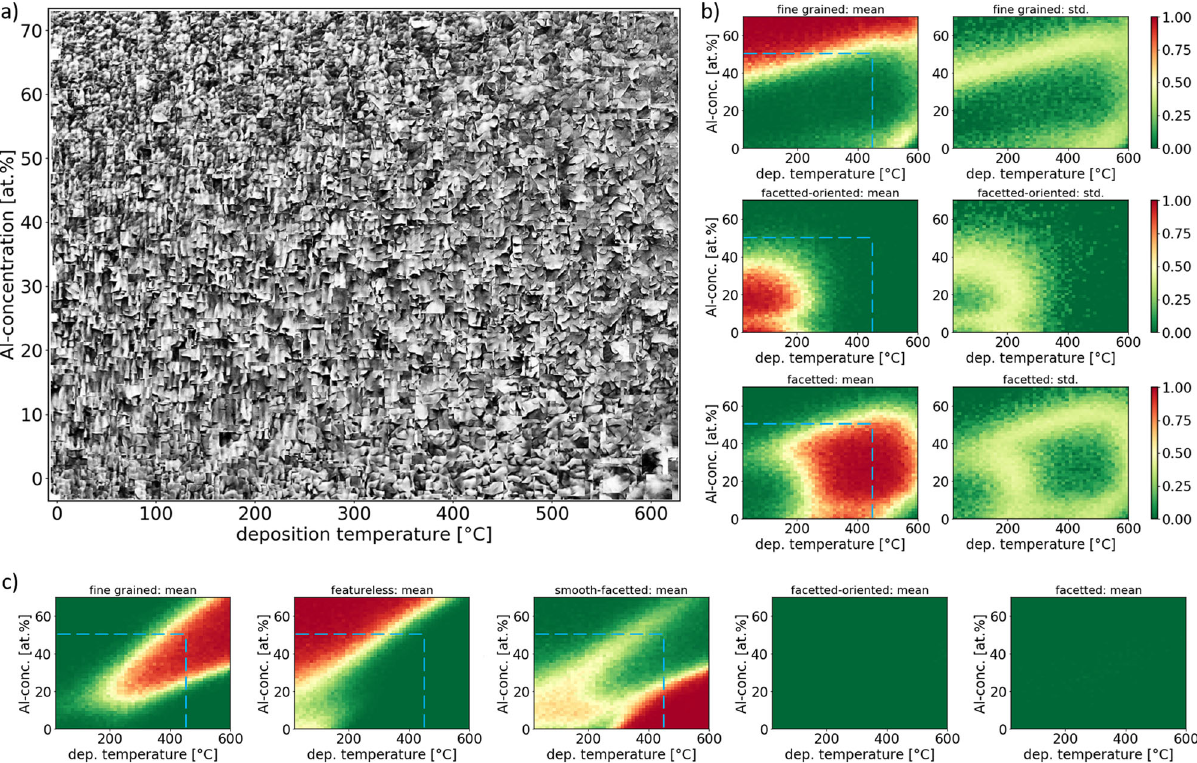
Fig. 6 Generated SZD and predicted microstructure classes. a gSZD generated by the cGAN model for a variation of Al und T d . The remaining conditional parameters were chosen to be I d = 1.0, E I = 40 eV, O = 1 at%, P d = 0.5 Pa. Panel b shows the average probability and standard deviation of the predicted microstructure classes of the gSZD by the CNN. The dashed blue lines indicate the technological boundary of the use case. Panel c shows the predicted microstructure classes for an increased E I of 200